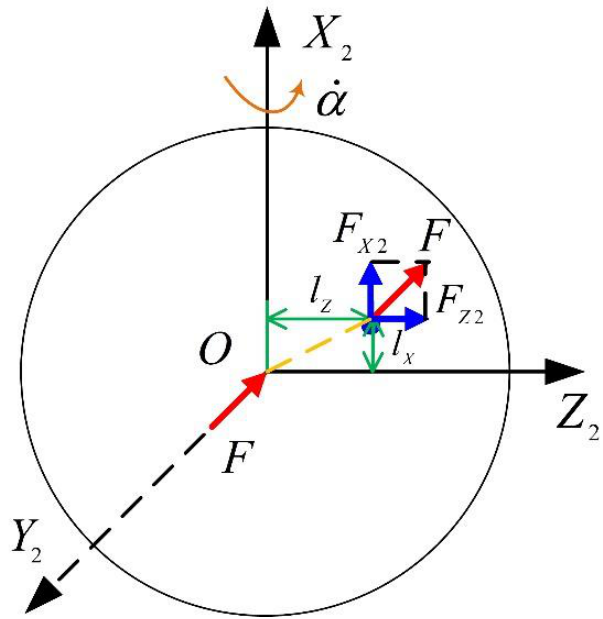
Figure 5. Force on the float due to unequal stiffness.